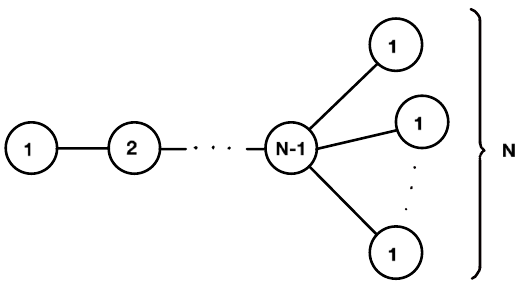
Figure 12. B-theory